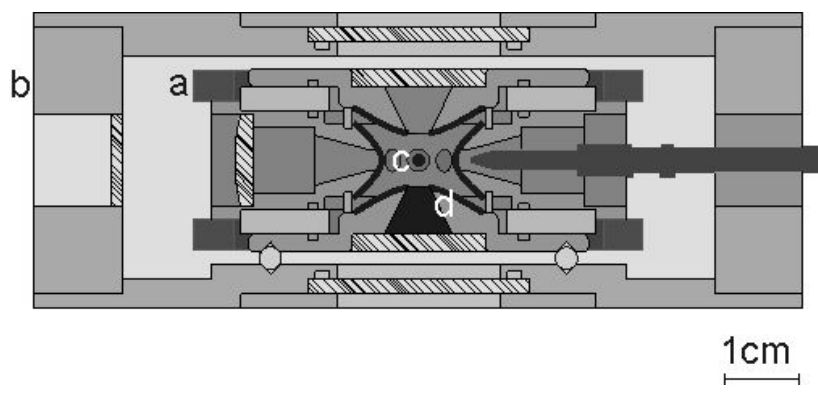
Fig. 2. Cross-section of the temperature controlled levitator [a] inside a vacuum chamber [b]. The microdroplet [c] is centered amidst the ice covered electrodes [d] and above an ice reservoir. From the right hand side droplets will be injected and there is also optical access in axial an radial direction.